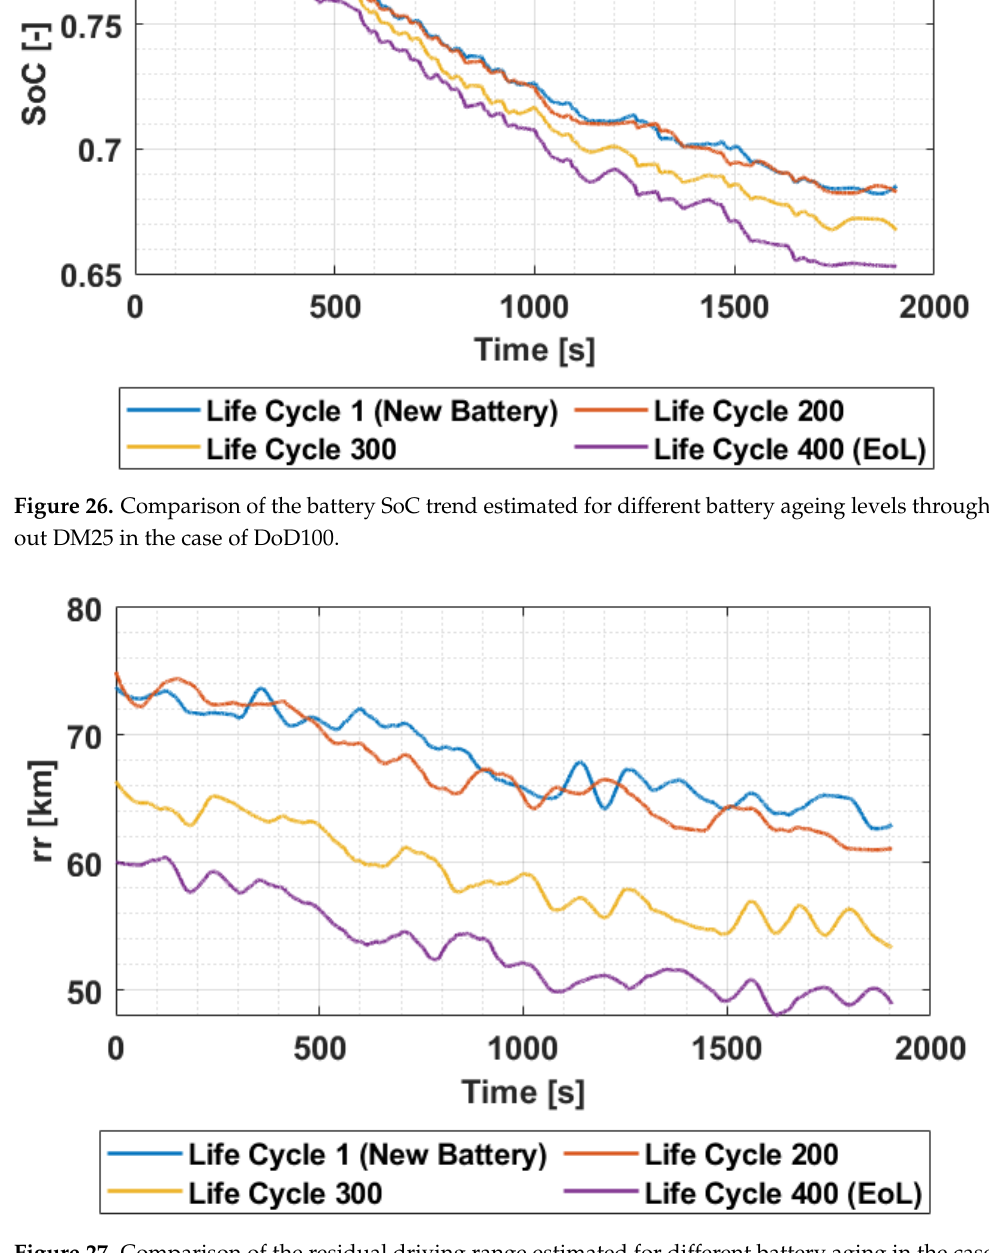
Figure 27. Comparison of the residual driving range estimated for different battery aging in the case of DoD100.